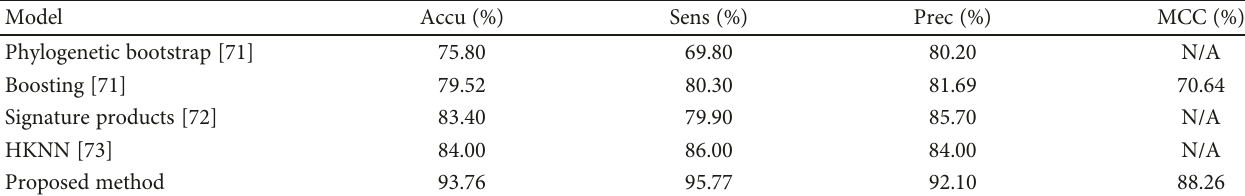
Table 6: Performance comparison of di ff erent methods on the H. pylori